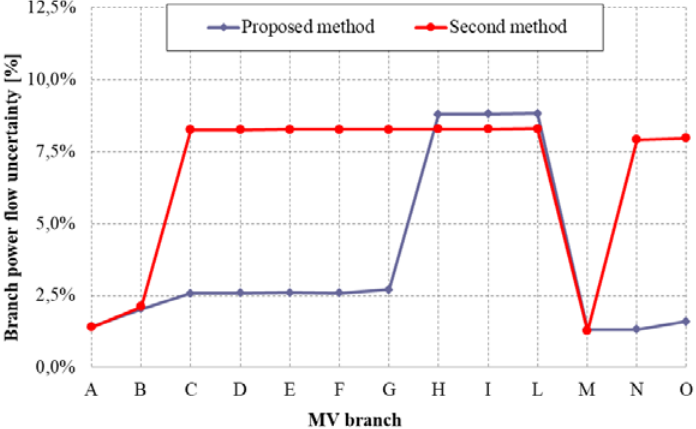
Figure 6. Branch power flow uncertainties (referring to the total power of the AUSL feeder) obtained when the number and position of PMs are changed.